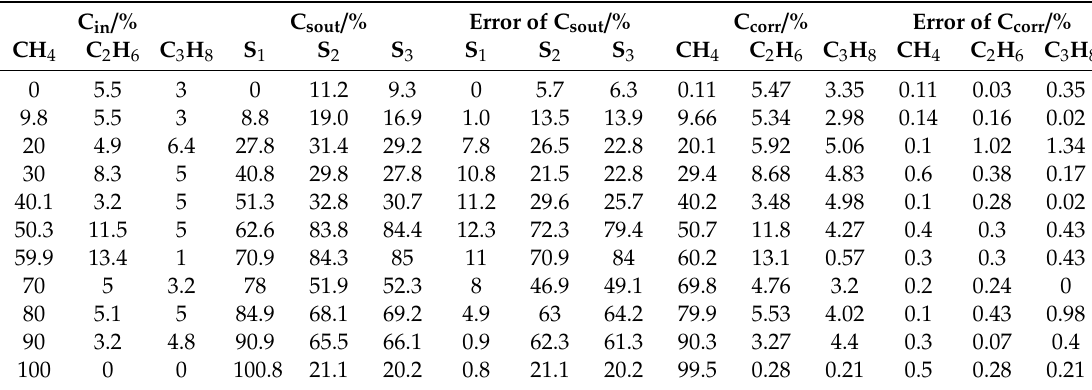
Table 3. Comparison of sensor output and recognition system output.